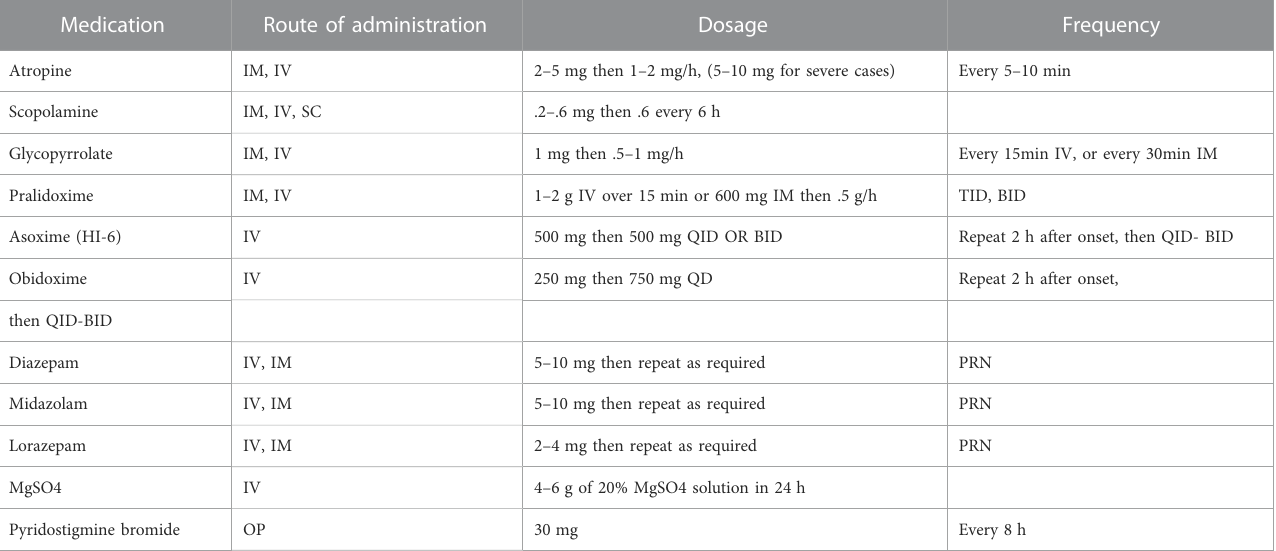
TABLE 3 Dosage of the recommended